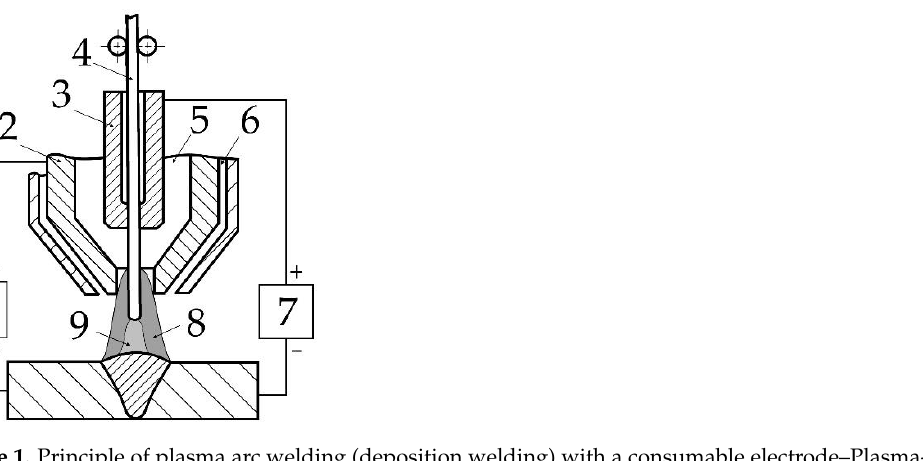
Figure 1. Principle of plasma arc welding (deposition welding) with a consumable electrode – Plasma-MIG: 1 – plasma arc power supply; 2 – non-consumable electrode; 3 – contact tip; 4 – consumable electrode; 5 – plasma gas; 6 – shielding gas; 7 – power supply for the consumable electrode arc; 8 – plasma arc; 9 – consumable electrode arc.